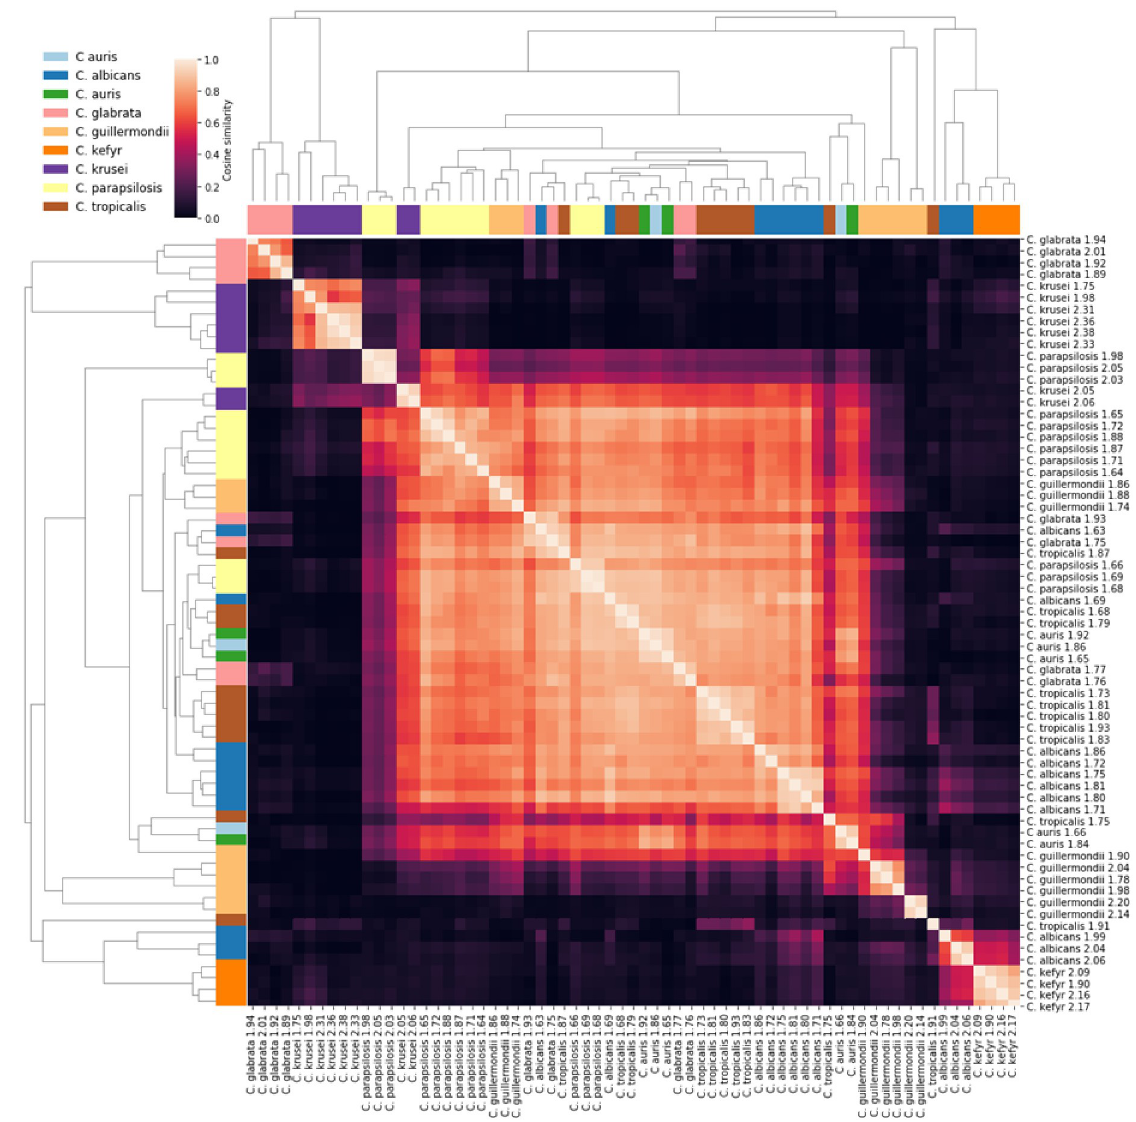
Fig 6. Heatmap of spectral similarities with dendrogram clustering analysis for FcMBL candida mass spectra (2,000–20,000m/z).